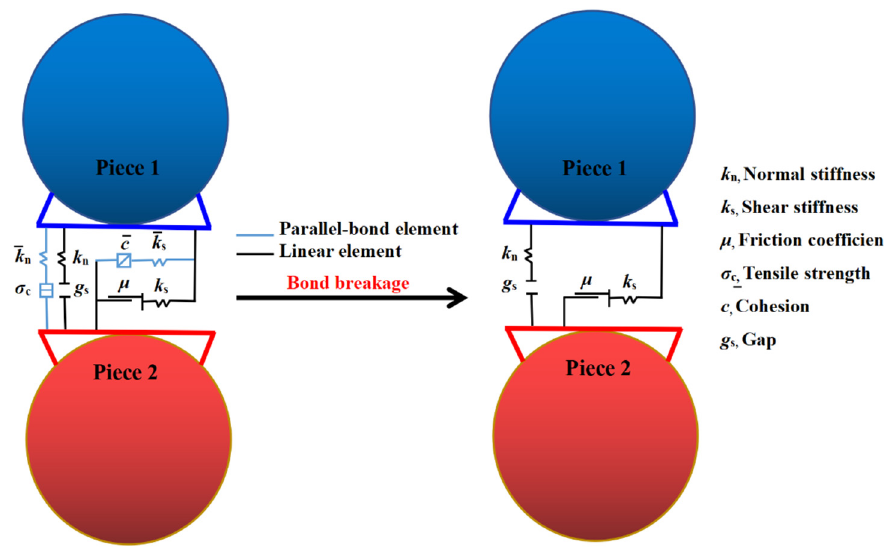
Figure 1. Failure transformation of linear parallel bonding. Aggregate is constructed through six discrete particle units embedded with each other, particle gradation, with particles of 2.5–5 mm accounting for 25% and particles of 5–10